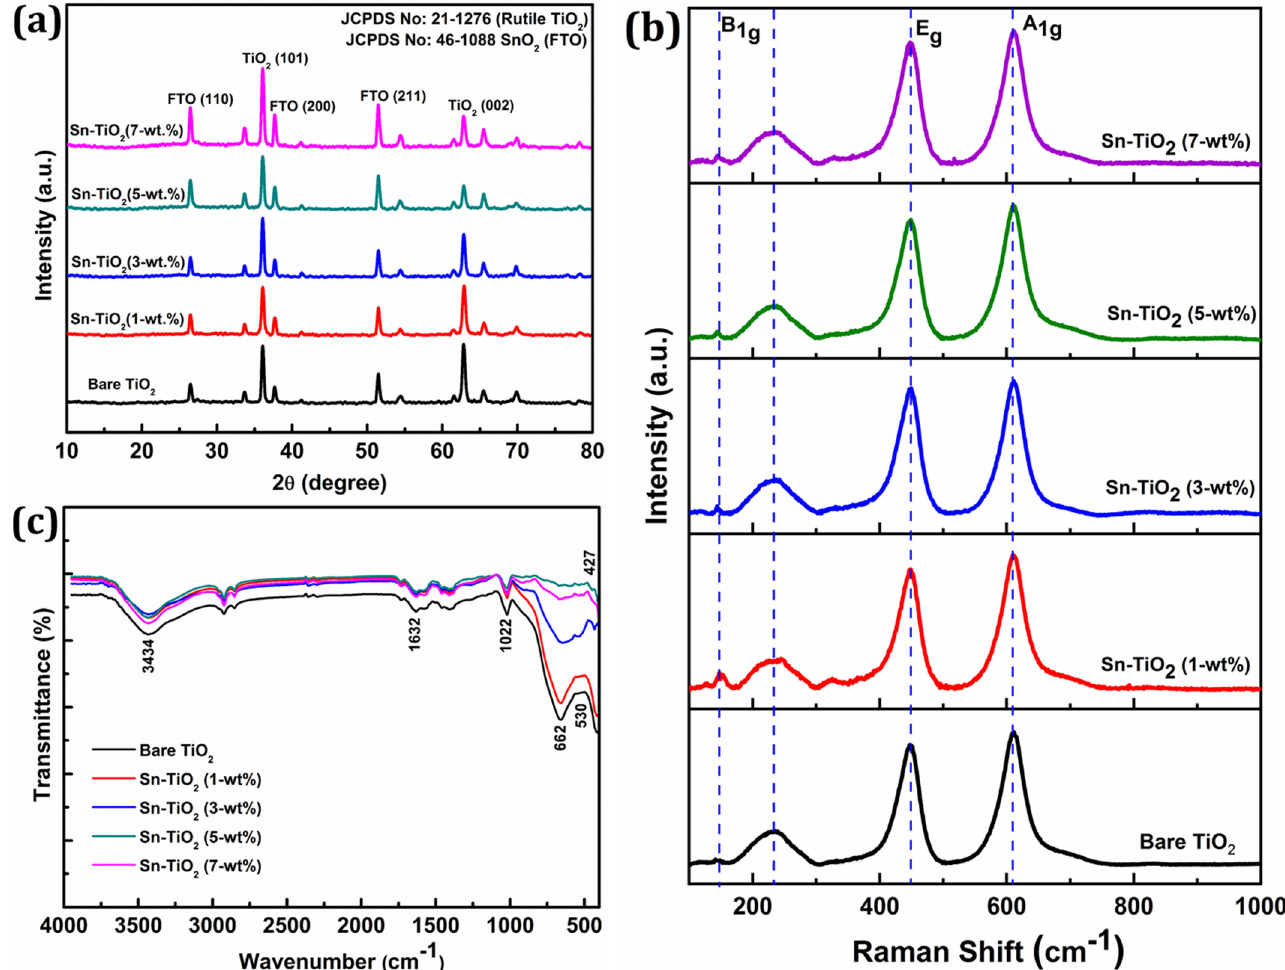
Figure 1. ( a ) XRD patterns, ( b ) Raman spectra, and ( c ) FT-IR spectra of hydrothermally synthesized bare TiO 2 , 1-wt %, 3-wt %, 5-wt %, and 7-wt % Sn-TiO 2 thin films.